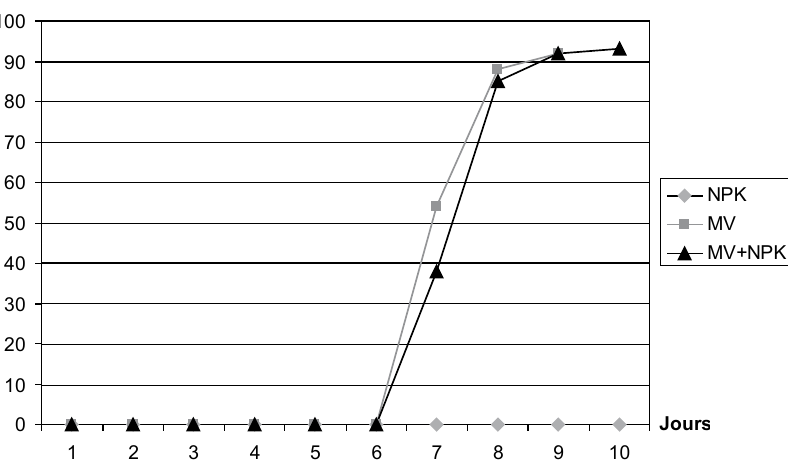
Fig. 2. – nombre cumulé d’adultes émergés dont les larves ont évolué dans les milieux contenant de la matière végétale (mV), de l’engrais nPK et un mélange de